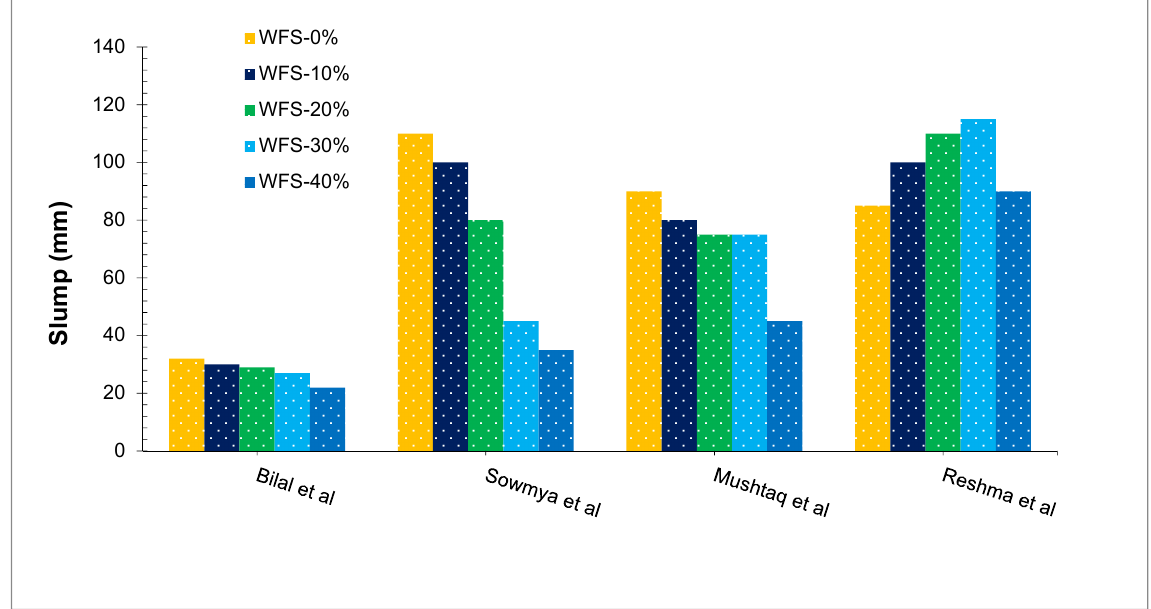
Figure 3. Slump with WFS: Bilal et al. [43], Sowmya et al. [50], Mushtaq et al. [51] and Reshma et al. [52].